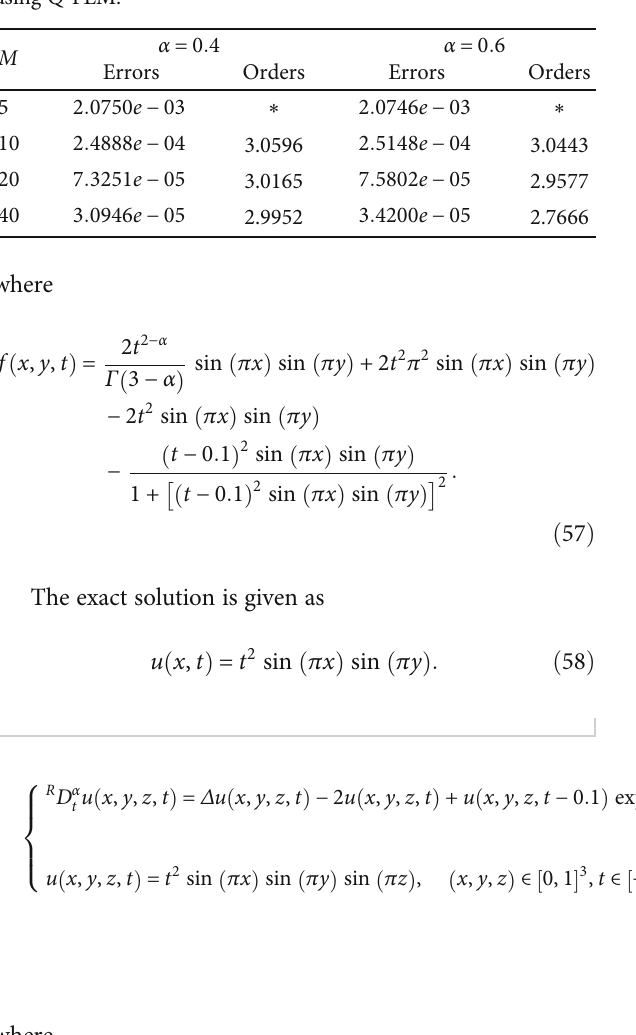
Table 5: The errors and orders in temporal direction and spatial direction by using Q-FEM.